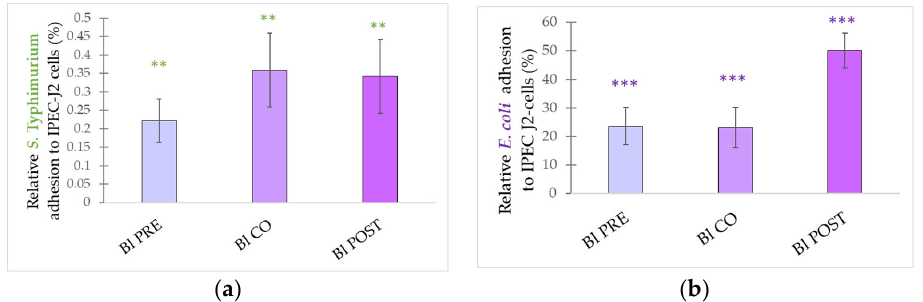
Figure 10. Inhibitory effect of B. licheniformis on S. Typhimurium ( a ) and E. coli ( b ) adhesion to IPEC-J2 cells. S. Typhimurium and E. coli adhesion inhibitions were determined upon incubation with B. licheniformis added 1 h before (pre-treatment), at the same time as (co-treatment), and 1 h after (post-treatment) the addition of S. Typhimurium and E. coli , respectively. B. licheniformis was added in 10 8 CFU/mL. Bl PRE : pre-treatment with B. licheniformis 10 8 CFU/mL + E. coli or S. Typhimurium 10 6 CFU/mL; Bl CO : co-treatment with B. licheniformis 10 8 CFU/mL + E. coli or S. Typhimurium 10 6 CFU/mL; Bl POST : post-treatment with B. licheniformis 10 8 CFU/mL + E. coli or S. Typhimurium 10 6 CFU/mL. Data are shown as means with standard deviations and expressed as relative adhesion, considering the mean value of only S. Typhimurium or E. coli treated cells as 100%. n = 6/group. Significant difference: ** p ≤ 0.01, in green: compared with treatment with S. Typhimurium. *** p ≤ 0.0001, in purple: compared with treatment with E. coli .